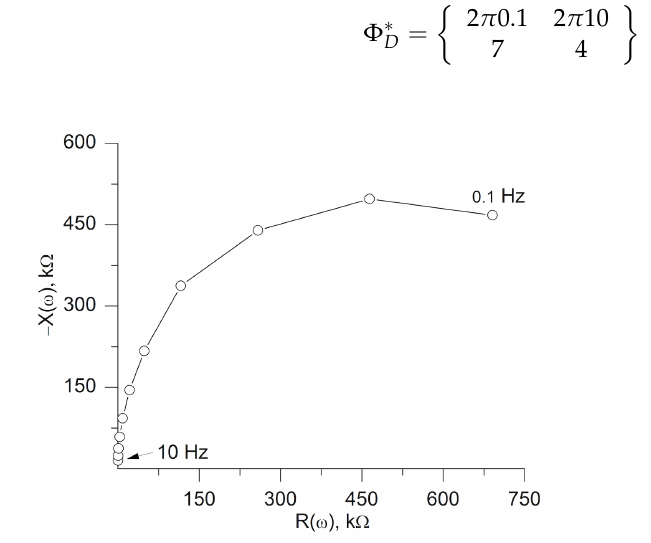
Figure 4. Nyquist plot obtained from the classic design. Table 1. EEC parameters values estimated using the different optimal designs.